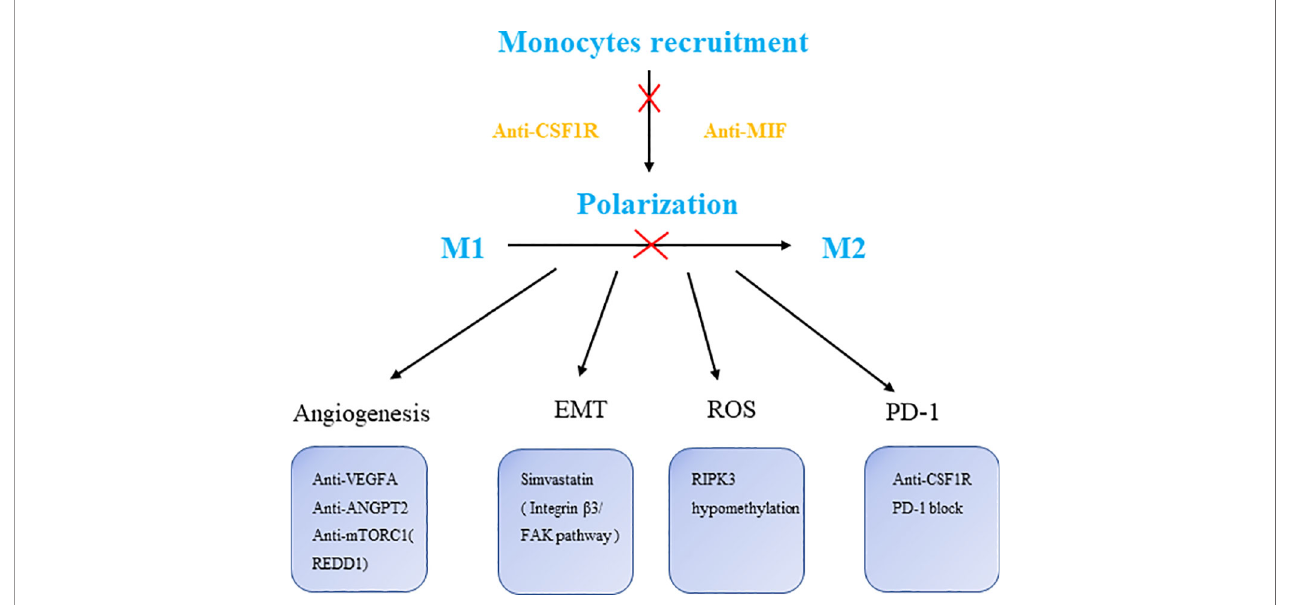
FIGURE 2 | The targets of macrophage therapies. CSF1R, colony stimulating factor 1 receptor; MIF, macrophage migration inhibitory factor; VEGFA, vascular endothelial growth factor A; ANGPT2, angiopoietin-2; RIPK3, receptor-interacting protein